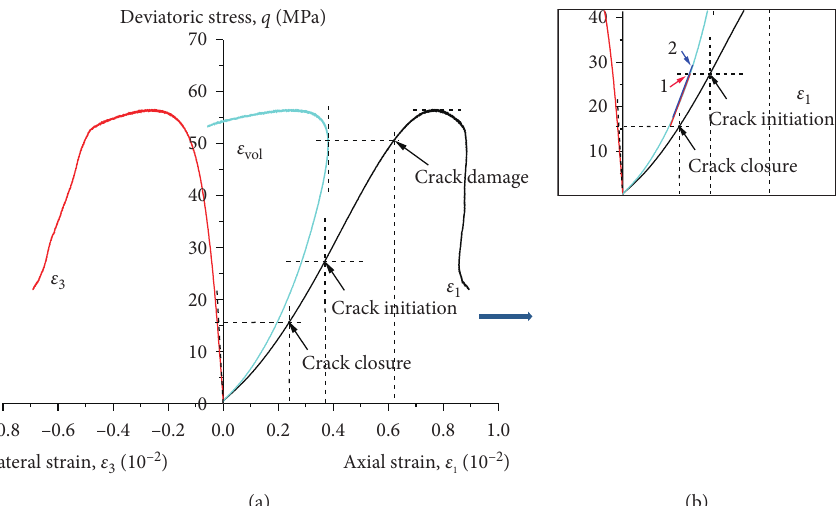
Figure 1: Damage threshold confirming curves by Brace’s method: (a) the damage point of rocks; (b) the subjective error analysis [16].